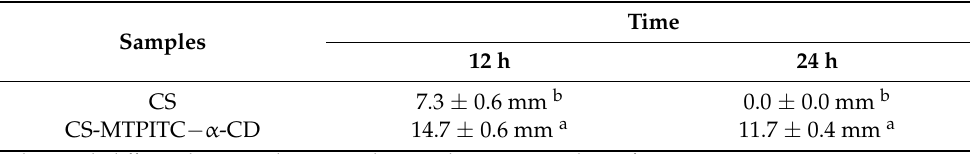
Table 1. The diameters of the inhibition zones of the CS and CS-MTPITC- α -CD films against S. typhimurium